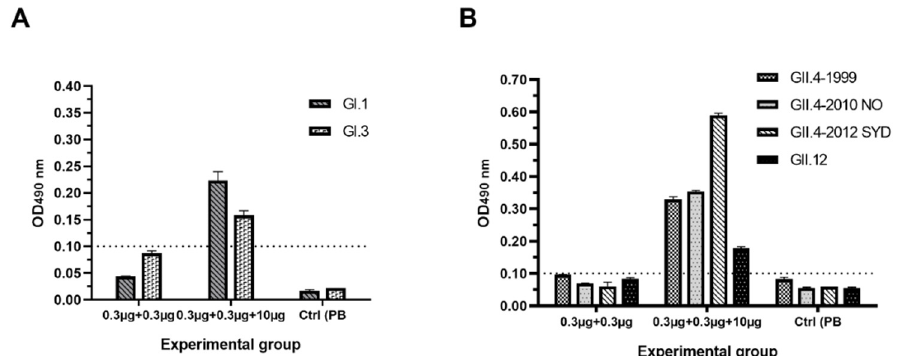
Figure 4. Serum norovirus (NoV)-specific cross-reactive IgG antibodies. Pooled termination sera of experimental groups receiving 0.3 µg NoV GI.4 and GII.4-2006a VLPs alone or mixed with 10 µg of RV VP6 were diluted 1:200 and tested for cross-reactive IgG against two NoV ( A ) GI VLPs and ( B ) four GII VLPs. Control (Ctrl) mice received carrier only (PBS). Mean OD values with the standard errors are shown for replicate analysis.